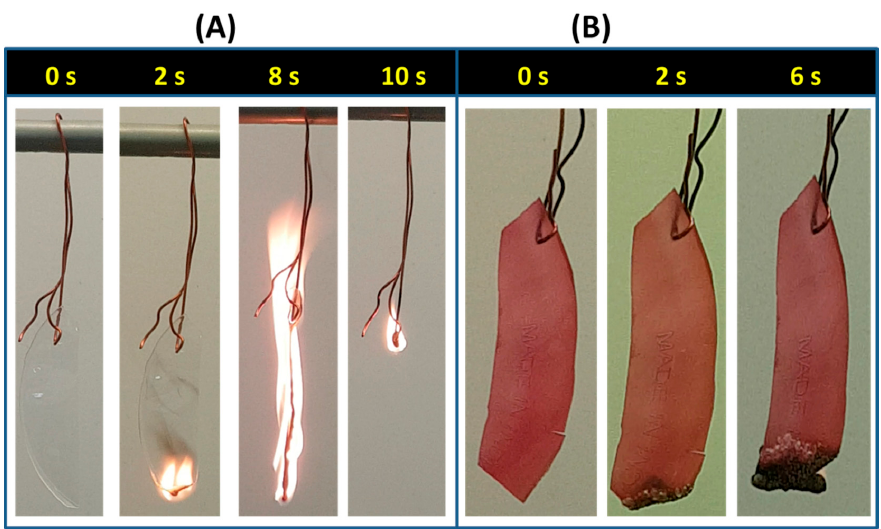
Figure 5. Burning test for the ( A ) neat PVA film, and ( B ) PVA-15 NCF crosslinked at 135 °C for 45 min.